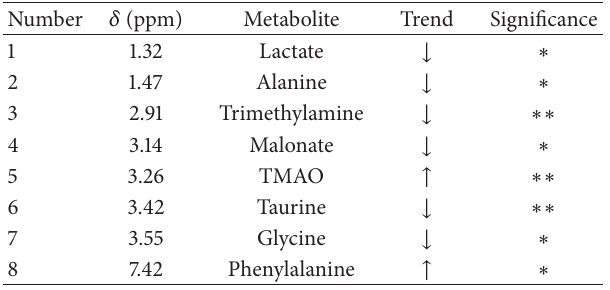
Table 2: List of peaks intensity with 𝑃 < 0.05 from urinary spectra of first two